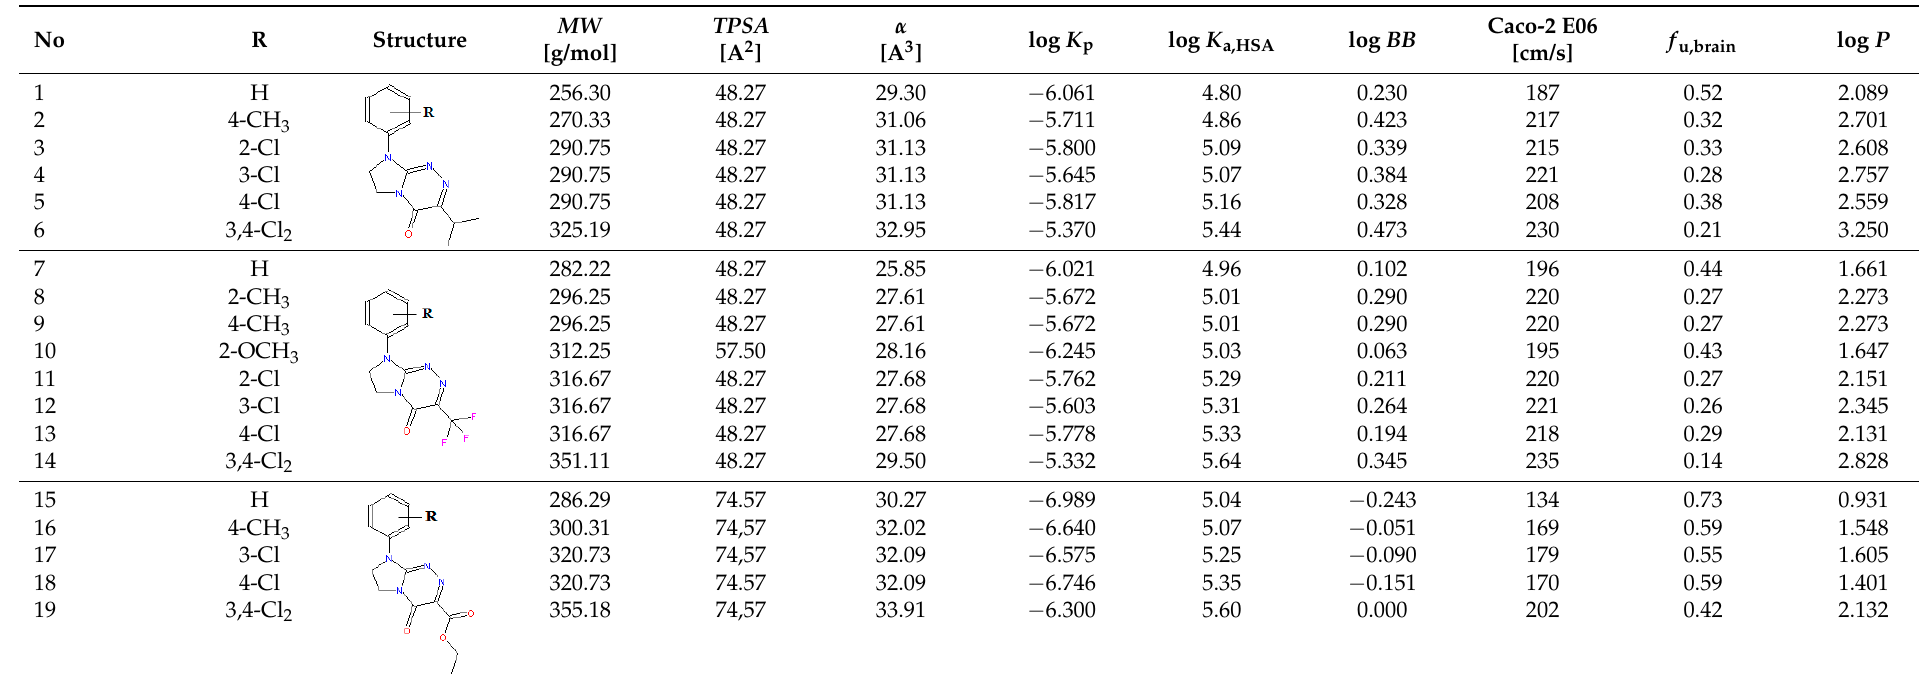
Table 1. The compounds tested and their structure, molecular weight ( MW ), topological polar surface area ( TPSA ), polarizability ( α ), pharmacokinetic parameters (log K p , log K a,HSA , log BB , Caco-2, f u.brain ), and lipophilicity (log P ). No